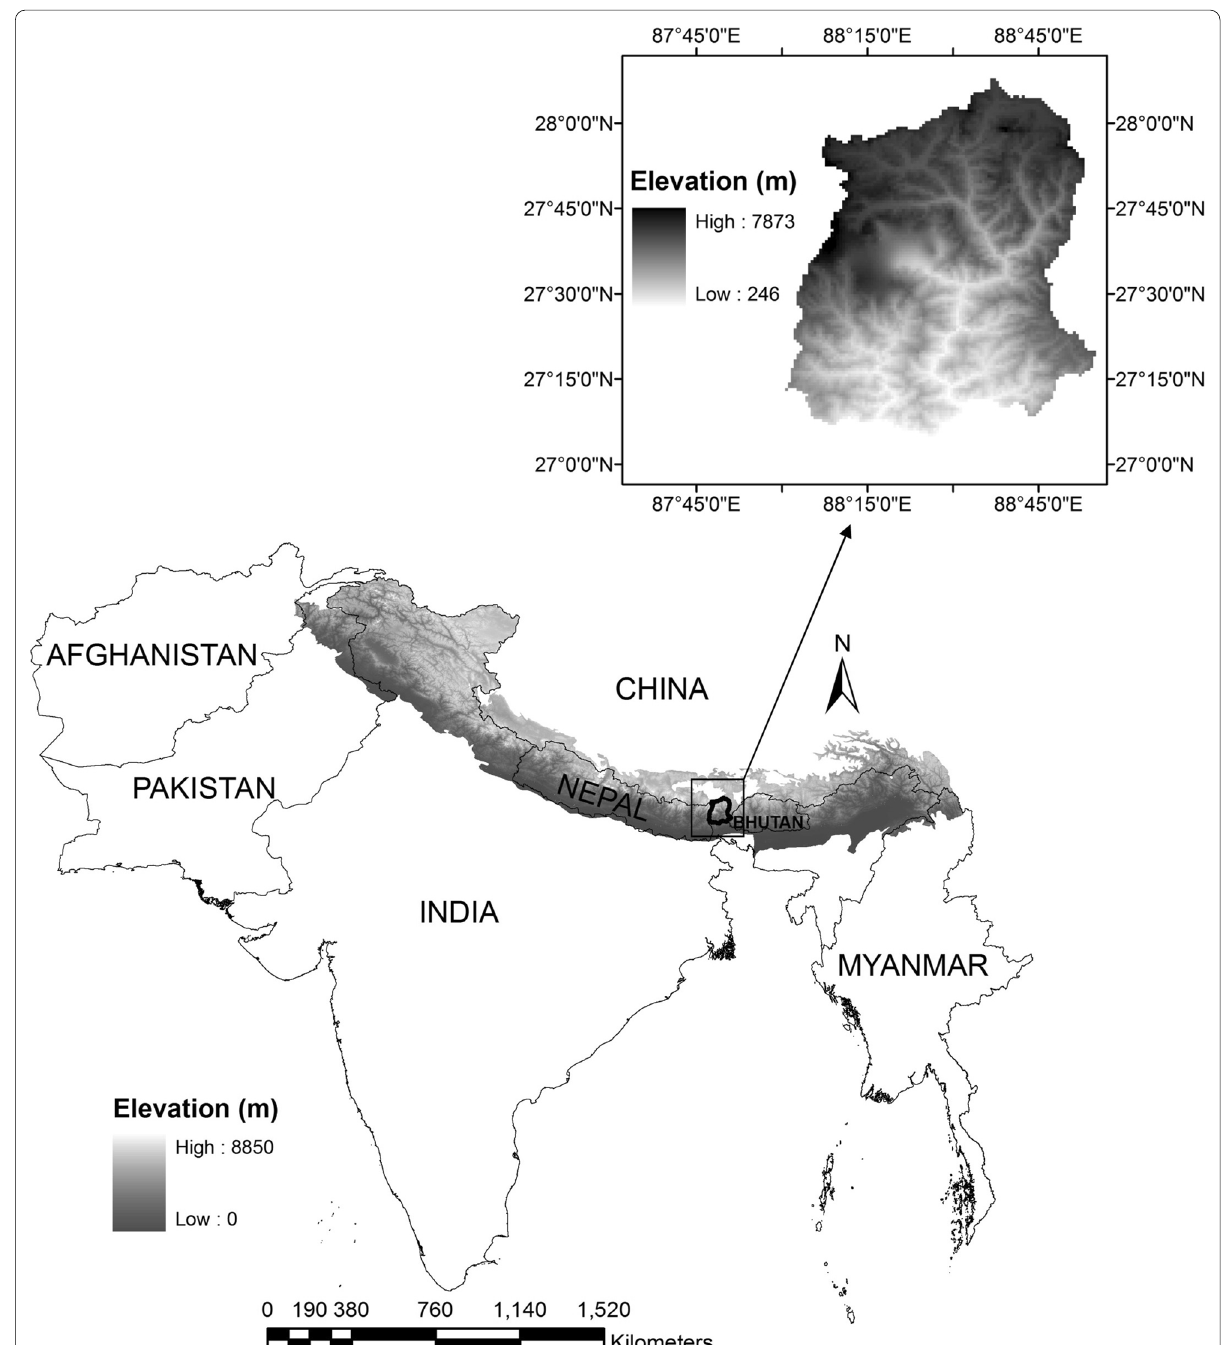
Fig. 1 Map showing the geographical and elevational extent of the Himalayan mountain system. The inset figure within the box on the right-hand side depicts the elevational gradient of the study area (Sikkim Himalaya, a part of the Eastern Himalaya biodiversity